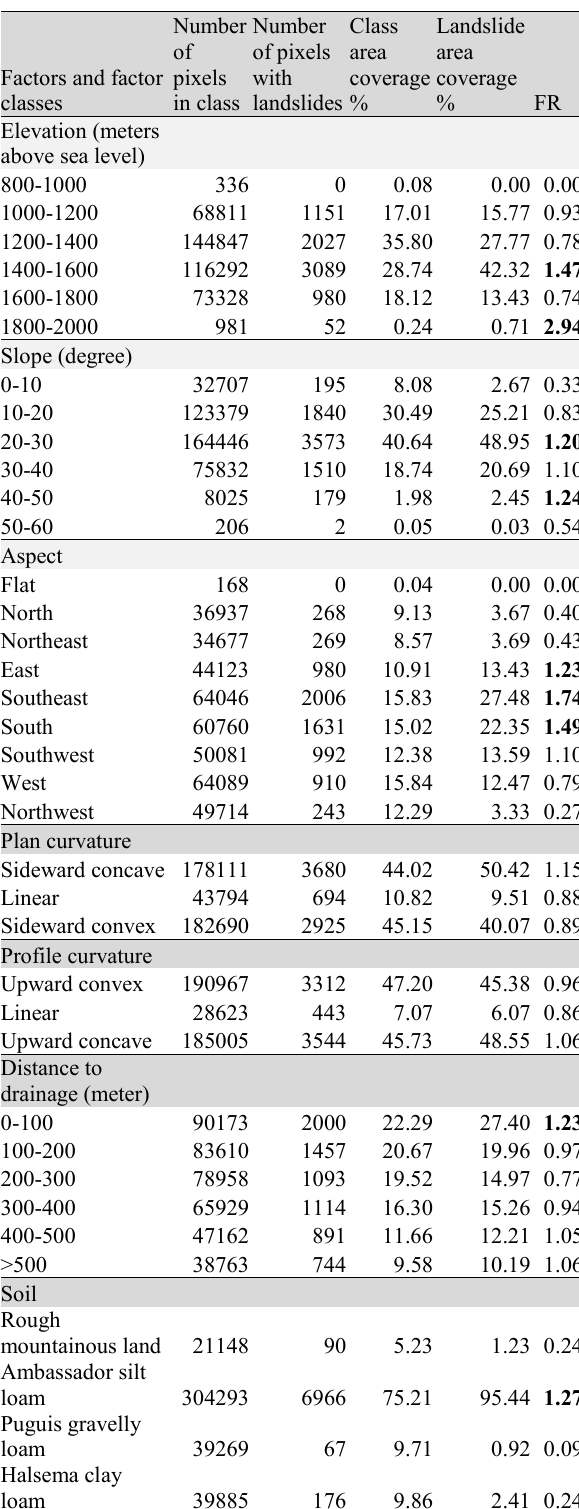
Table 2a. Landslide conditioning factors, factor class and